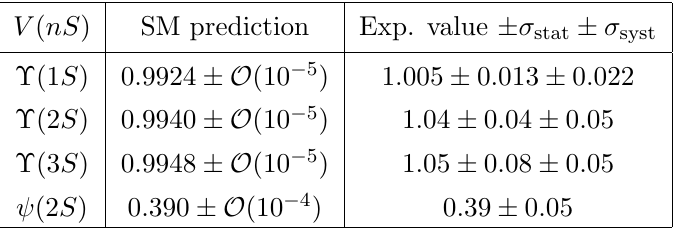
Table 1. Experimental results and SM predictions for R V